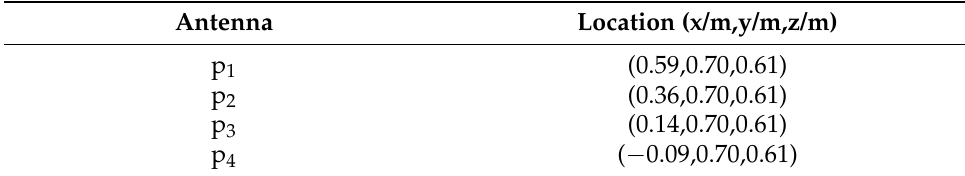
Figure 10. Test case 1. 3D domain. Table 1. Antenna